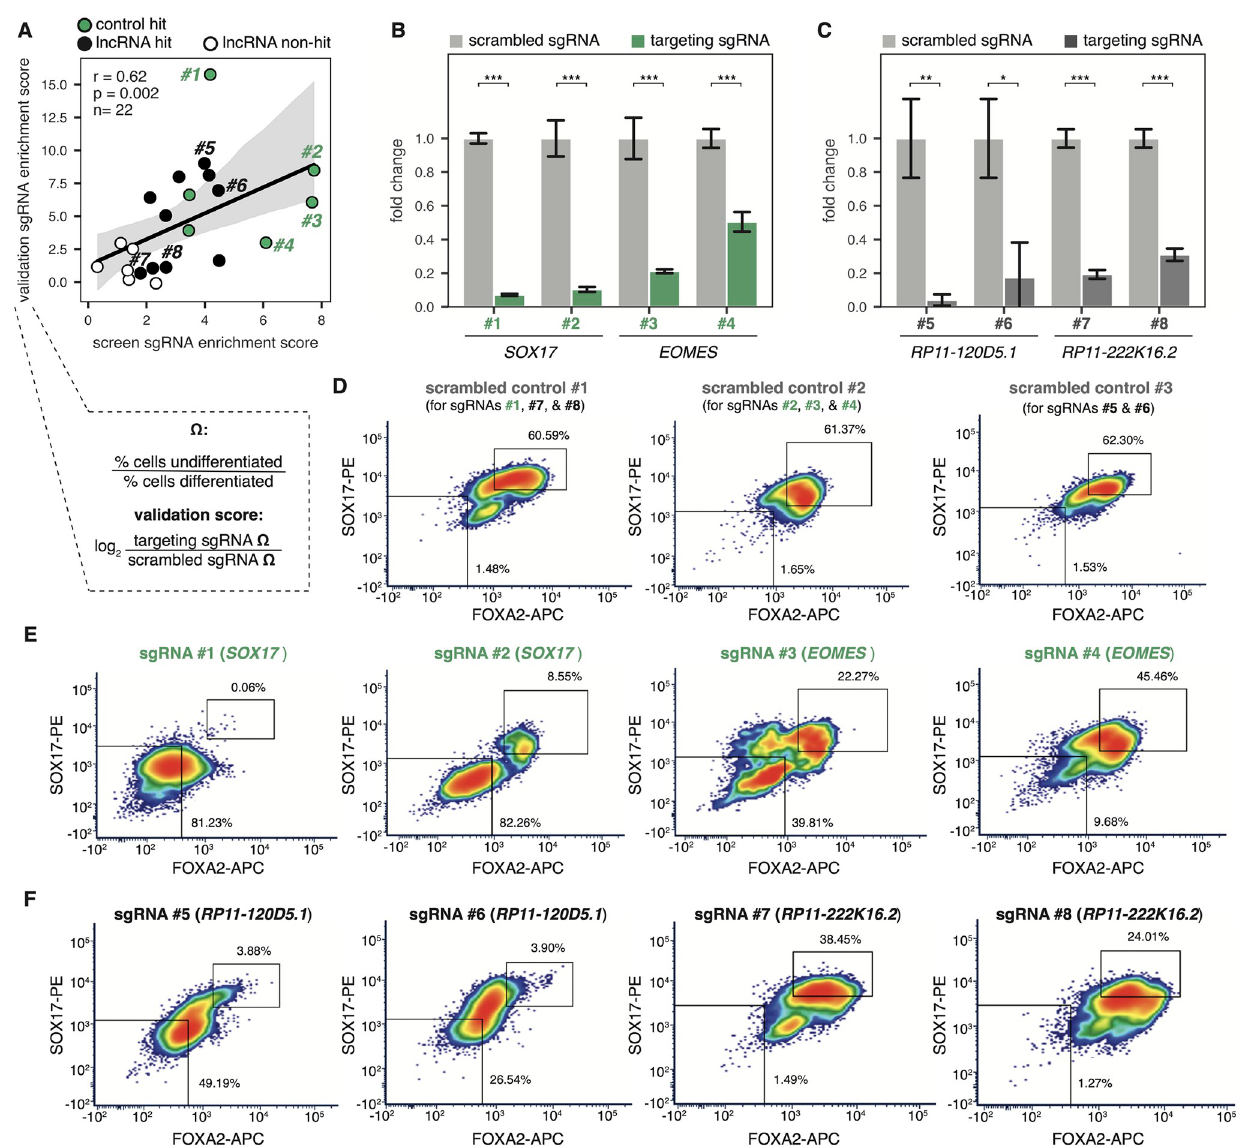
Fig 4. CRISPRi screen reveals several lncRNA loci required for endoderm differentiation. (A) Correlation of the validation sgRNA score and the screen sgRNA score for all 22 sgRNAs validated, colored by whether the sgRNAs target control mRNA hits (green), lncRNA hits (black), or lncRNA non-hits (white). Validation scores were calculated according to the formula outlined. Example validation data for 8 sgRNAs targeting 2 control mRNA and 2 lncRNA hits are shown in (B)-(F); the full dataset is in S4 Table. r = Spearman’s rho, p = Spearman p-value, n = # sgRNAs. (B) RT-qPCR expression of mRNA SOX17 (sgRNAs #1 and #2) or EOMES (sgRNAs #3 and #4) during endoderm differentiation using either a scrambled negative control sgRNA (light gray bars) or a targeting sgRNA (green bars). Labeled sgRNA numbers correspond to those outlined in (A). ��� = p-value < 0.001 by an unpaired t- test. (C) RT-qPCR expression of lncRNA RP11-120D5 . 1 (sgRNAs #5 and #6) or RP11-222K16 . 2 (sgRNAs #7 and #8) during endoderm differentiation using either a scrambled negative control sgRNA (light gray bars) or a targeting sgRNA (dark gray bars). Labeled sgRNA numbers correspond to those outlined in (A). � = p-value < 0.05, �� = p-value < 0.01, ��� = p-value < 0.001 by an unpaired t-test. (D) FACS staining of scrambled negative control sgRNAs during endoderm differentiation, with percentages of differentiated cells (top right box) and undifferentiated cells (bottom left box) labeled. Three separate endoderm differentiation time courses were performed to validate the 8 outlined sgRNAs. Scrambled sgRNA #1 was run as a negative control for targeting sgRNAs #1, #7, and #8; scrambled sgRNA #2 was run as a negative control for targeting sgRNAs #2, #3, and #4; scrambled sgRNA #3 was run as a negative control for targeting sgRNAs #5 and #6. (E) FACS staining of mRNA-targeting sgRNAs #1–4 during endoderm differentiation, with percentages of differentiated cells (top right box) and undifferentiated cells (bottom left box) labeled. (F) FACS staining of lncRNA-targeting sgRNAs #5–8 during endoderm differentiation, with percentages of differentiated cells (top right box) and undifferentiated cells (bottom left box) labeled.